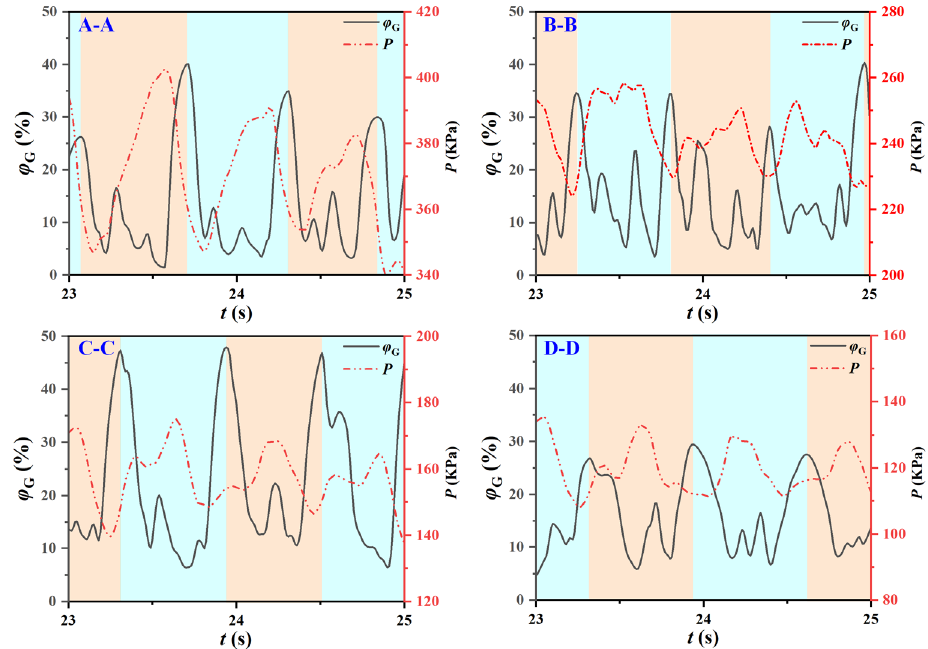
Figure 10. Fluctuations of the pressure and gas volume fraction in the middle cross-sections of the four bends in the case of Q G = 6 kg/s and Q L = 144 kg/s.